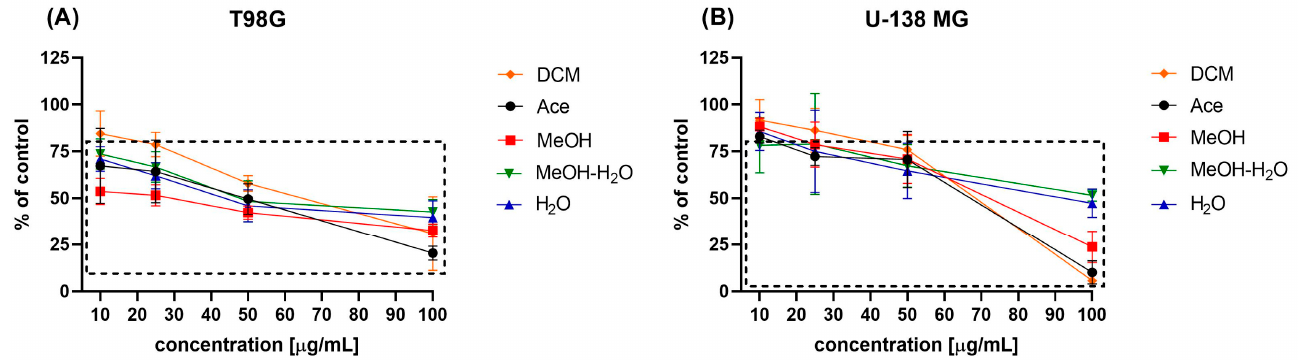
Figure 6. The effects of dichloromethane (DCM), acetone (Ace), methanol (MeOH), methanol-water (MeOH-H 2 O) and water (H 2 O) extracts of P. glauca on GBM cell viability (panel ( A )—T89G cell line, panel ( B )—U-138 MG cell line) after 48 h of treatment. Data presented as mean values ± SEM from three independent experiments. Statistically significant results different from the DMSO treated control are presented inside the rectangle.